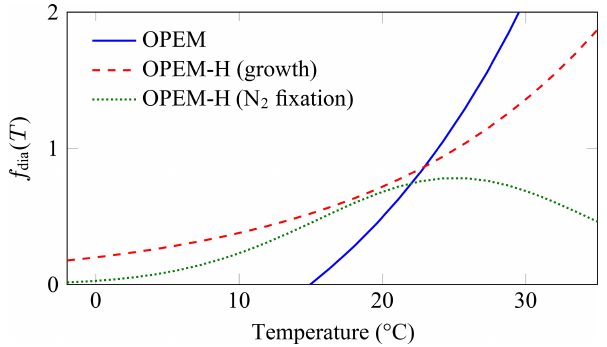
Figure 2. Temperature functions ( f dia (T ) ) for diazotrophs. The OPEM function (solid blue line) is the one employed by the original and OPEM configurations for both diazotroph growth and N 2 fix- ation. The OPEM-H configuration applies the Eppley (1972) func- tion (dashed red line) to nutrient uptake and CO 2 fixation to both or- dinary and diazotrophic phytoplankton and the Houlton et al. (2008) function (dotted green line) to N 2